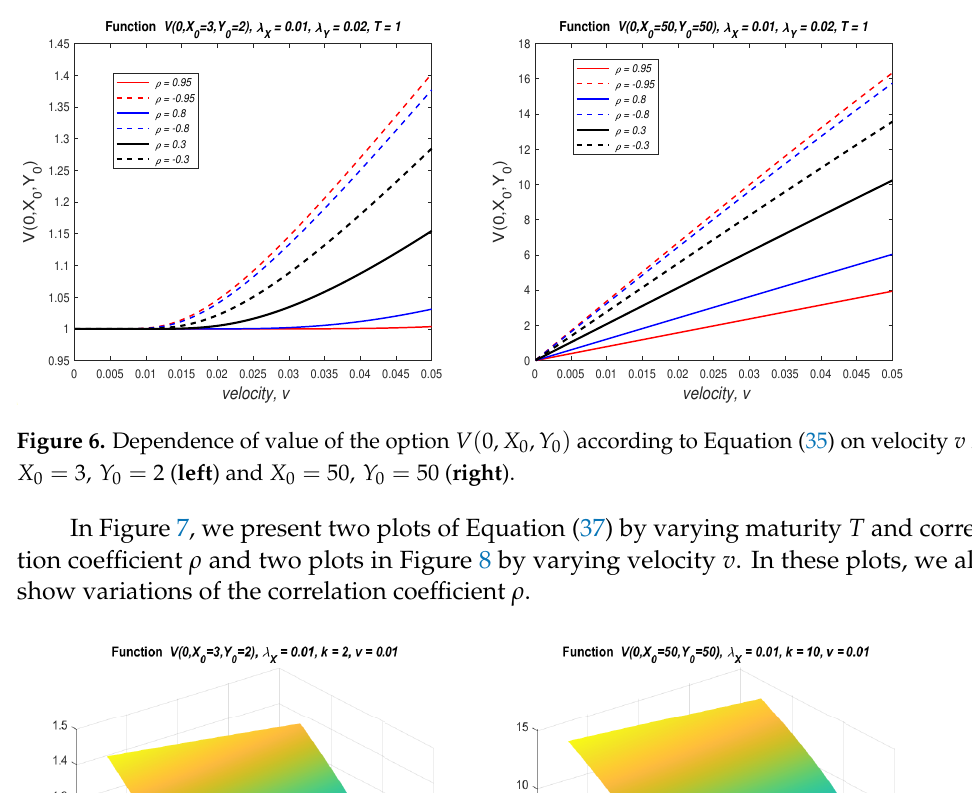
Figure 5. Dependence of the value of the option V ( 0, X 0 , Y 0 ) according to Equation (35) on maturity T for X 0 = 3, Y 0 = 2 ( left ) and X 0 = 50, Y 0 = 50 ( right ).